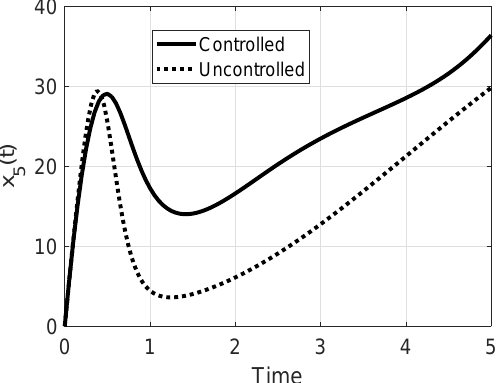
Figure 16. Case 5: evolution of the number of x 5 ( t ) with (continuous line) and without control (dotted